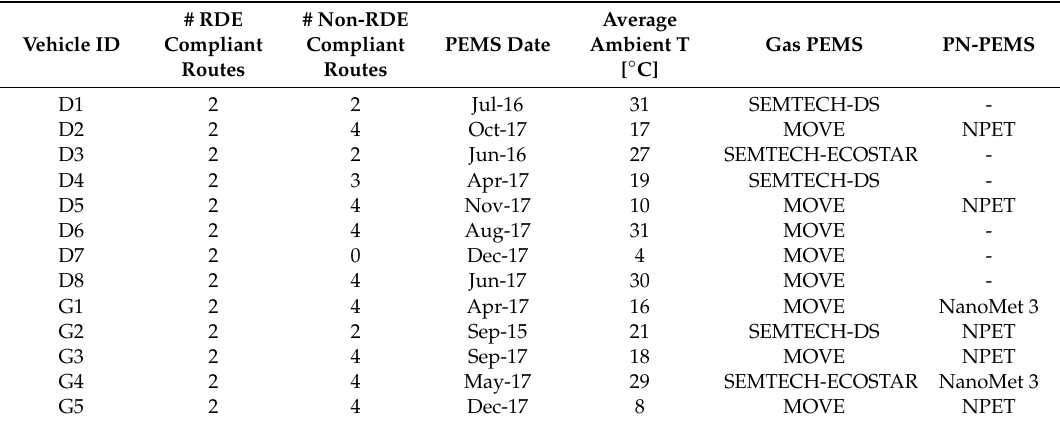
Table 3. On-road tests conducted with indication of number of routes per typology (Real-Driving Emissions regulation (RDE) and non-RDE), test campaign dates and average ambient temperature, and type of portable emissions measuring systems (PEMS)